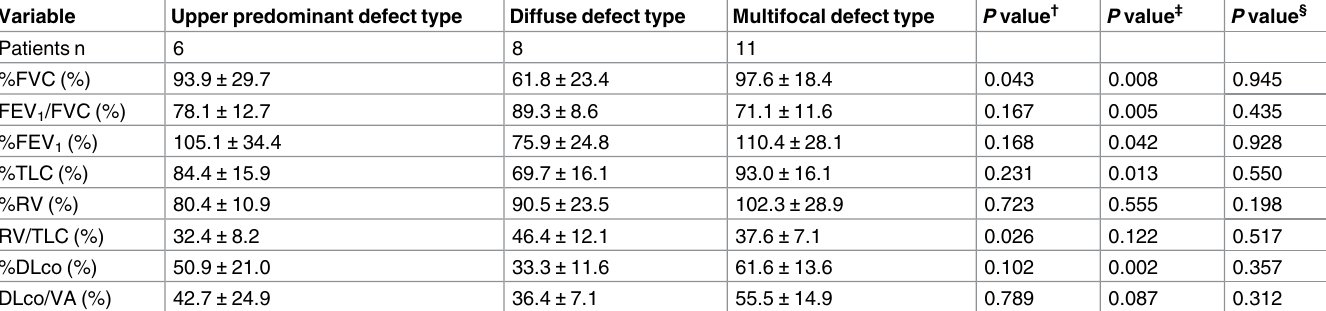
Table 4. The relationship between pulmonary function parameters and 3 different patterns in